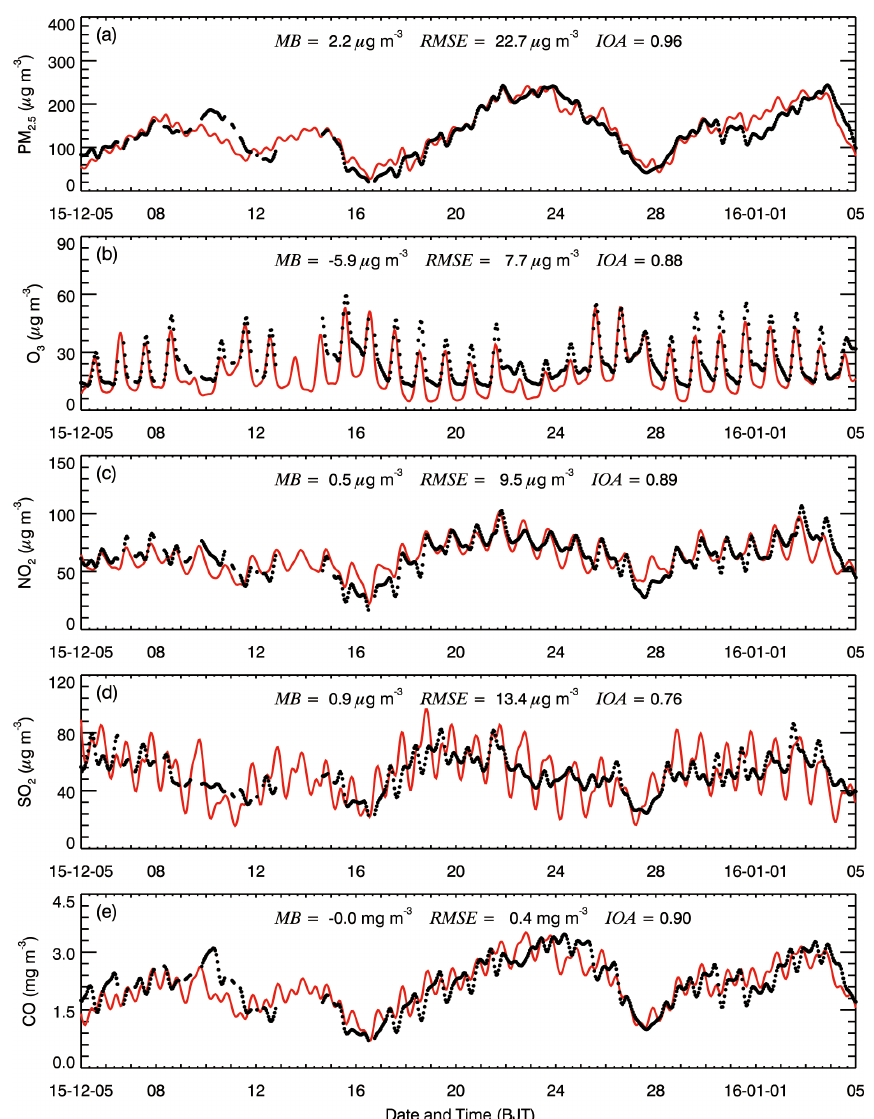
Figure 2. Comparison of observed (black dots) and simulated (solid red lines) diurnal profiles of near-surface hourly mass concentrations of (a) PM 2 . 5 , (b) O 3 , (c) NO 2 , (d) SO 2 , and (d) CO averaged at monitoring sites in the NCP from 5 December 2015 to 4 January